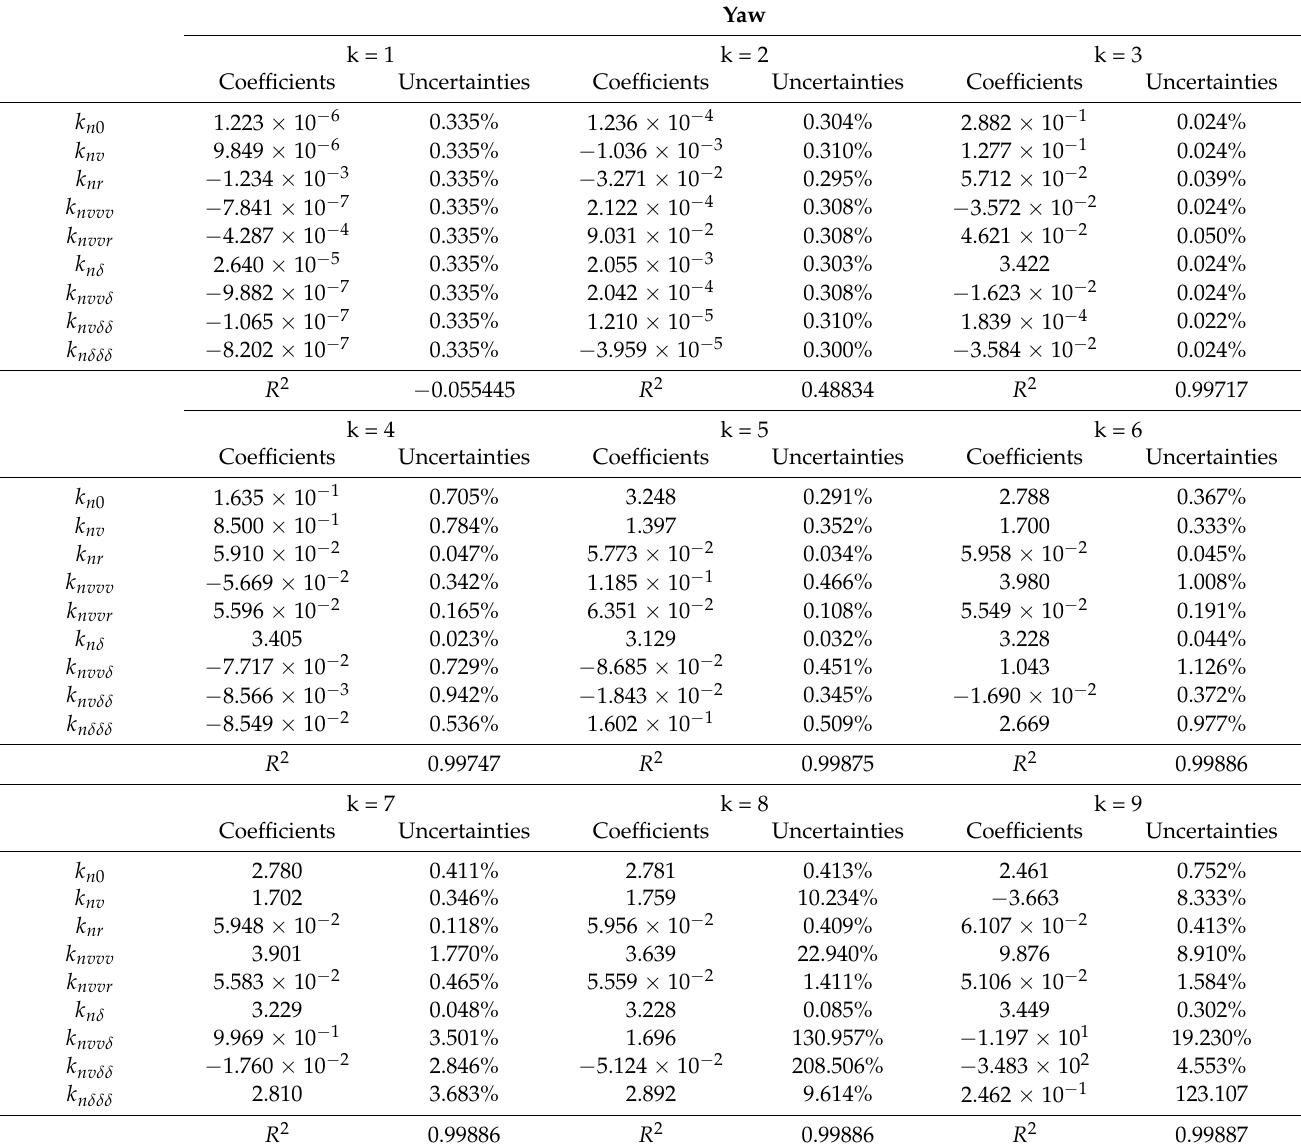
Table 4. Yaw adjustment coefficients and uncertainties for simulation of 25 ◦ turning manoeuvre.